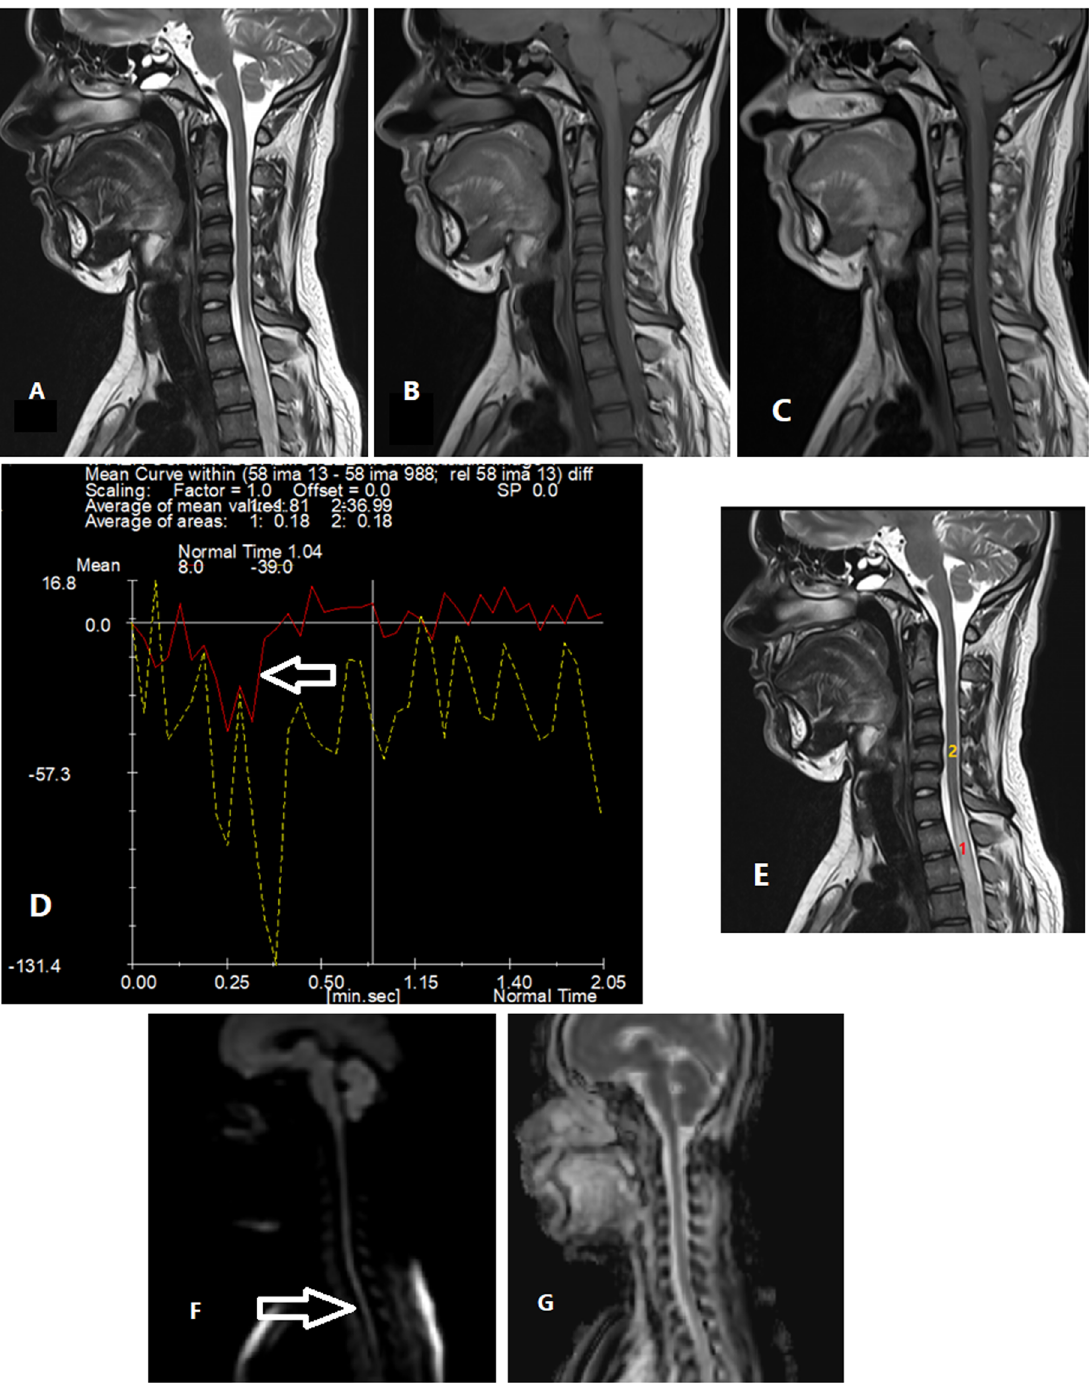
Fig. 3 18-year-old male presented with bilateral lower limb weakness. T2 sagittal cervico-dorsal spine ( A ) shows long segment of high signal intensity involving the cord opposite lower cervical and upper dorsal vertebrae. Pre-contrast T1 ( B ) and post-contrast T1 ( C ) show no significant post-contrast enhancement. D and E rCBV was calculated in comparison to normal cord (yellow curve) and the curve shows hypo perfusion of the lesion (arrow to red curve). DWI at b value 1000 ( F ) shows no areas of high signal intensity of the lesion (arrow) which appears also at ADC map = ( G ) denoting free diffusion. This lesion was diagnosed as neuromyelitis